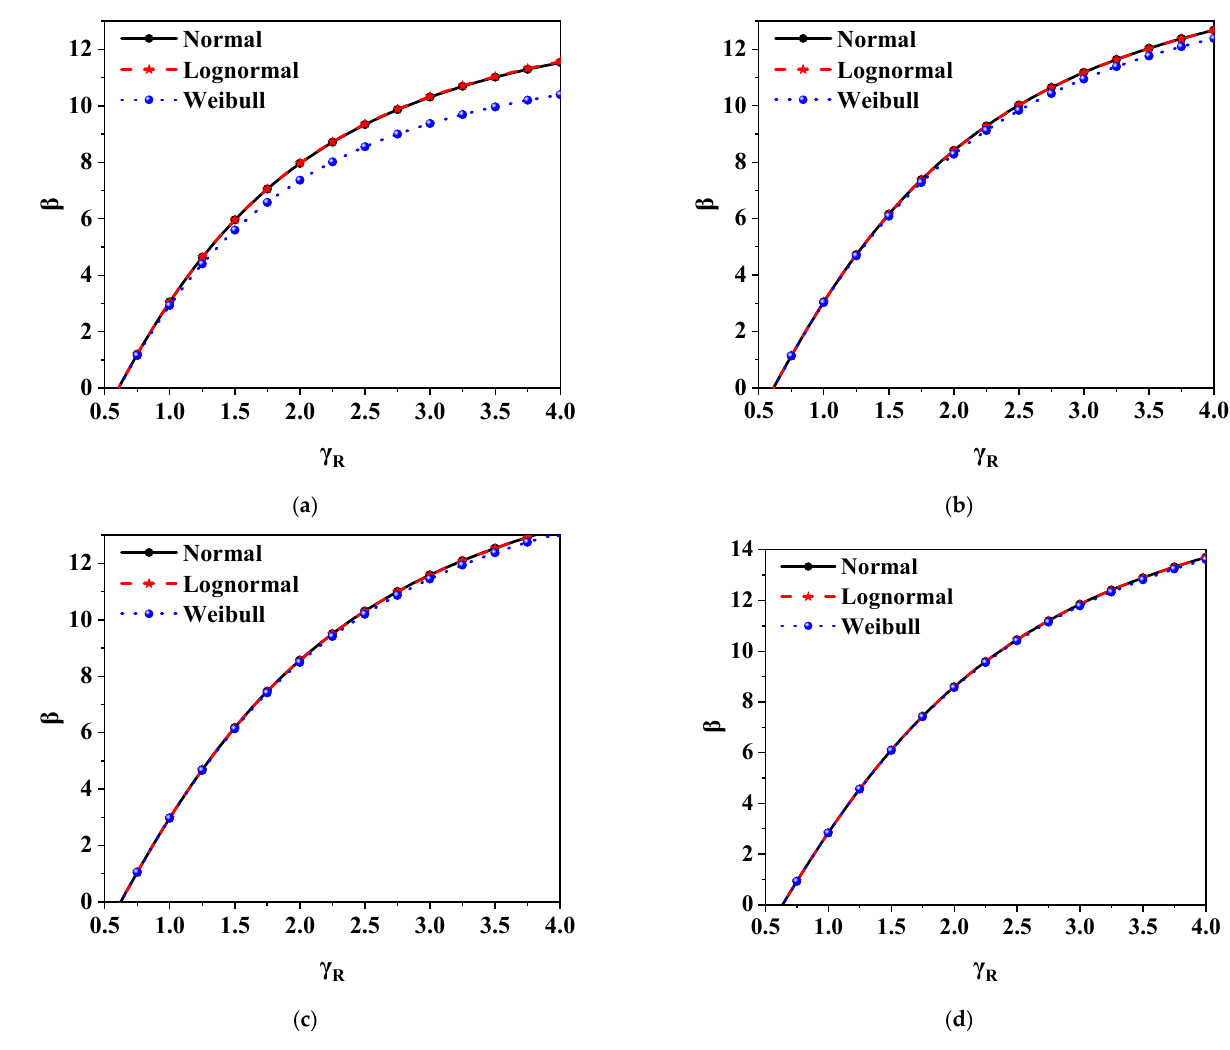
Figure 5. The relationship between β and γ R under different fitted data points and probability distribution types (grade II, constant load + live load of residential floor, ρ = 1.0): ( a ) n = 100%N; ( b ) n = 75%N; ( c ) n = 50%N; ( d ) n = 25%N.